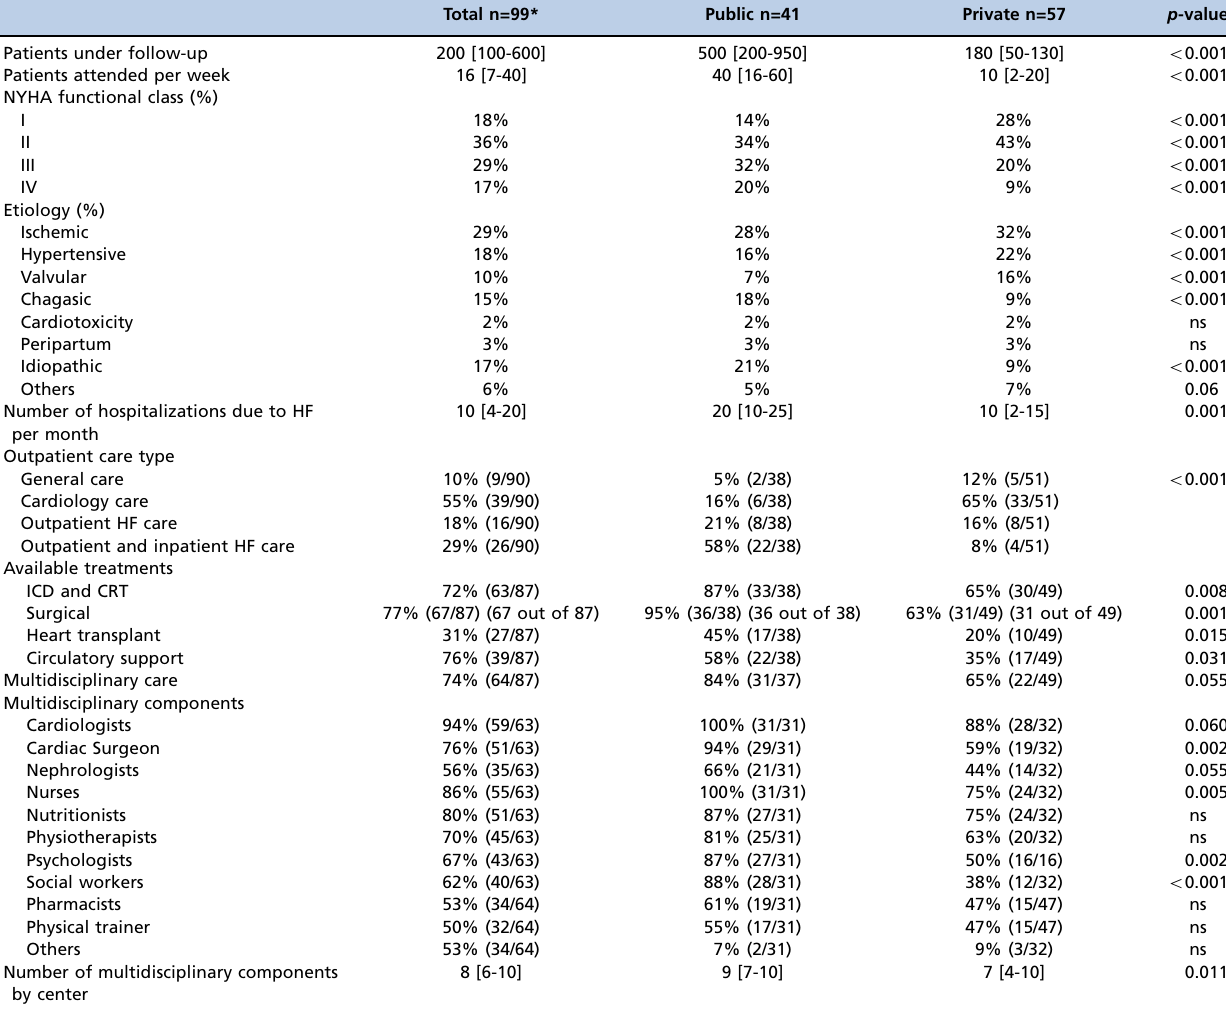
Table 1 - Demographic and Structure Data from Participating Sites Comparing Public versus